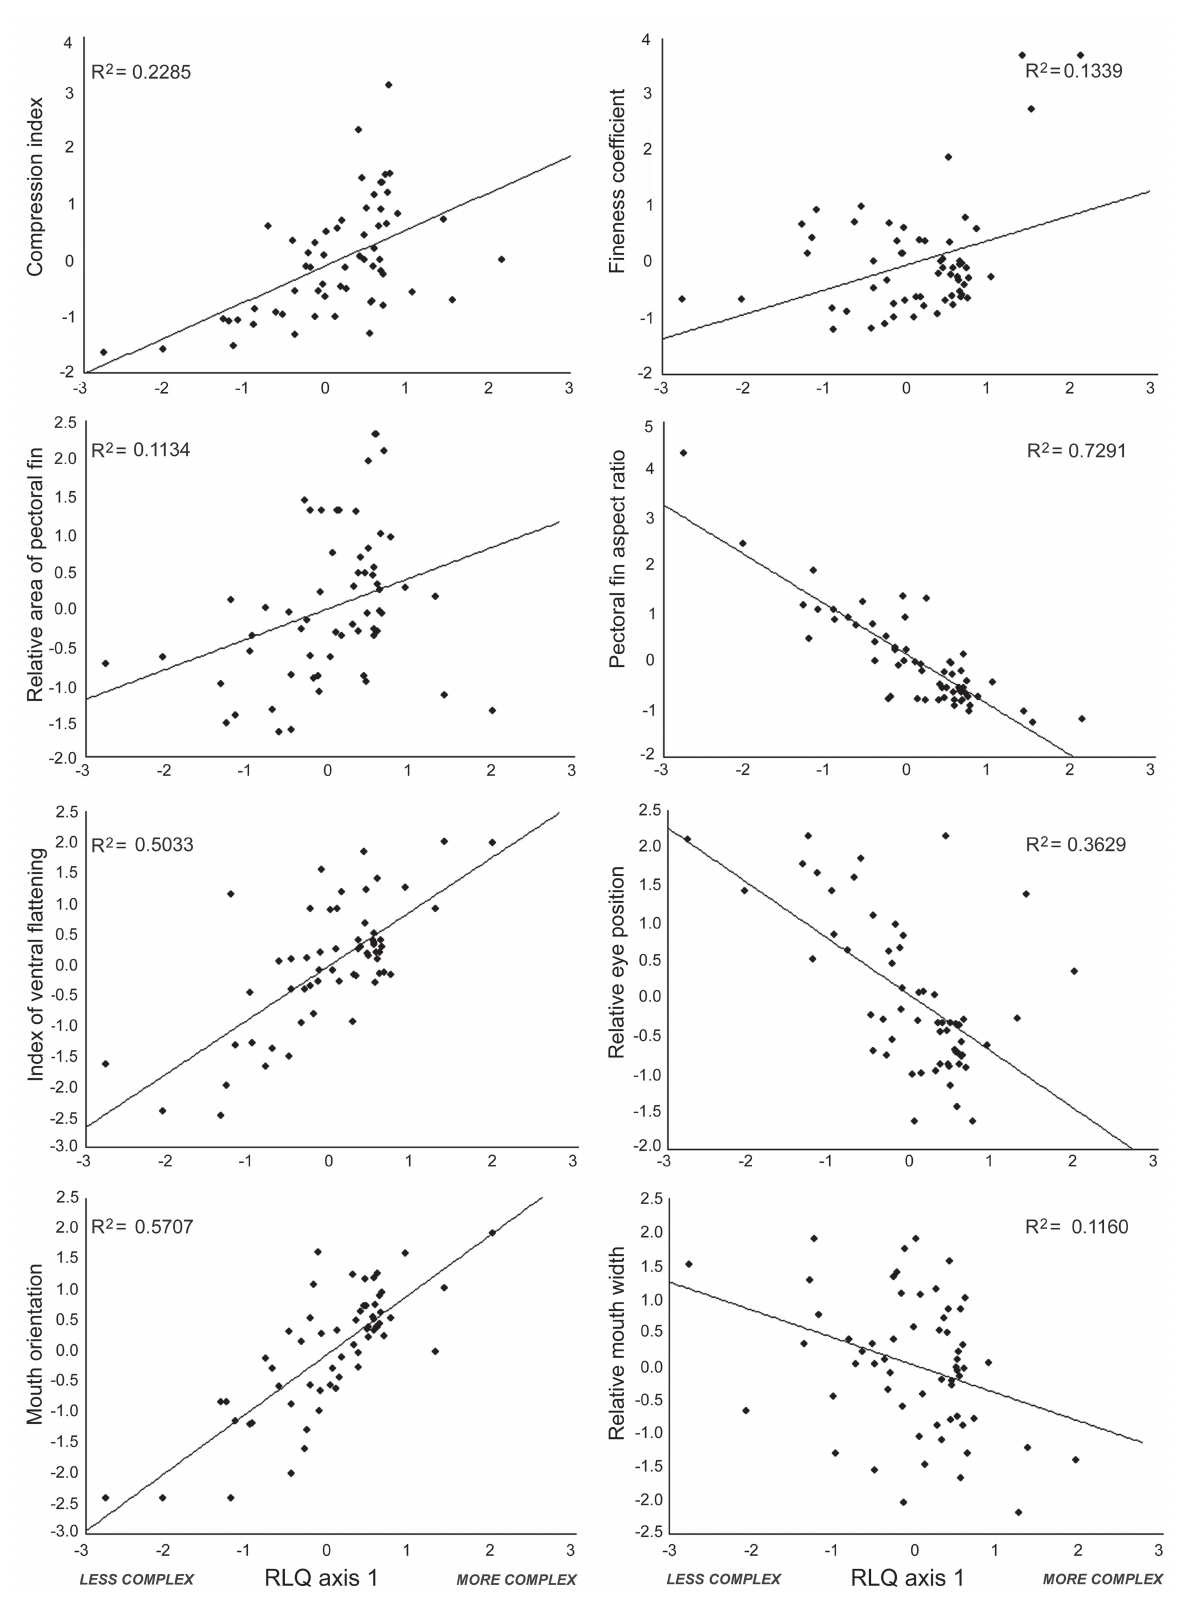
Fig. 4. Functional traits significantly correlated with the first RLQ axis (Pearson correlation, P < 0.005). In each graph, the first RLQ axis represents streams with banks covered by grasses and sandy bottom (less complex) and streams with banks covered by trees/shrubs and bottom with rocks/woody debris (more